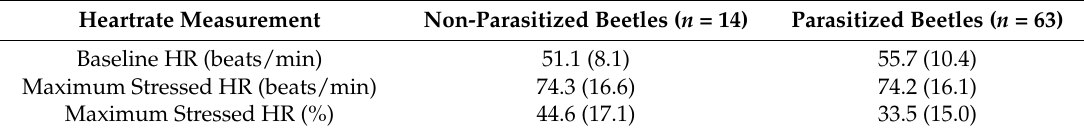
Table 3. Comparison of mean heartrate parameters between parasitized and non-parasitized beetles in the second experiment ( n = 77 wild beetles).